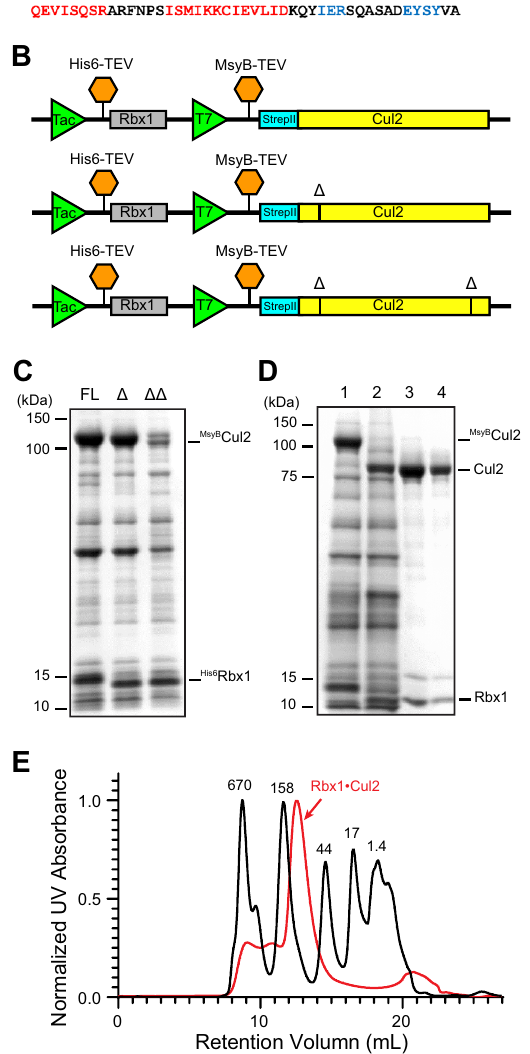
Figure 1. Expression of full-length RBX1•CUL2 in E. coli cells. ( A ) Secondary structures and disordered regions of CUL2 predicted by XtalPred. Red: helix; blue: strand; underlined: disordered region; shaded: deleted region in B-C . ( B ) Schematic illustrating strategies for expressing the full-length (FL) RBX1•CUL2 and its variants (RBX1•CUL2 FL , RBX1•CUL2Δ, and RBX1•CUL2ΔΔ). Each construct contains a His6 RBX1 coding sequence driven by a Tac promoter and a MsyB CUL2 coding sequence driven by a T7 promoter. Both His6 and MsyB can be cleaved by the TEV protease. Truncation sites (Δ) of CUL2 are shown as black lines. ( C ) RBX1•CUL2 FL , RBX1•CUL2Δ, and RBX1•CUL2ΔΔ extracted from E. coli cells transformed with plasmids shown in ( B ), using Ni-NTA beads. ( D ) Expression and purification of RBX1•CUL2 FL . Recombinant RBX1• StrepII CUL2 FL was purified through multiple steps, including Ni-NTA affinity chromatography (#1), incubation with the TEV protease to remove the His6 tag and MsyB fusion protein (#2), Strep-tag affinity chromatography (#3), and gel filtration (#4). ( E ) Chromatogram showing gel filtration elution peaks of the protein standards